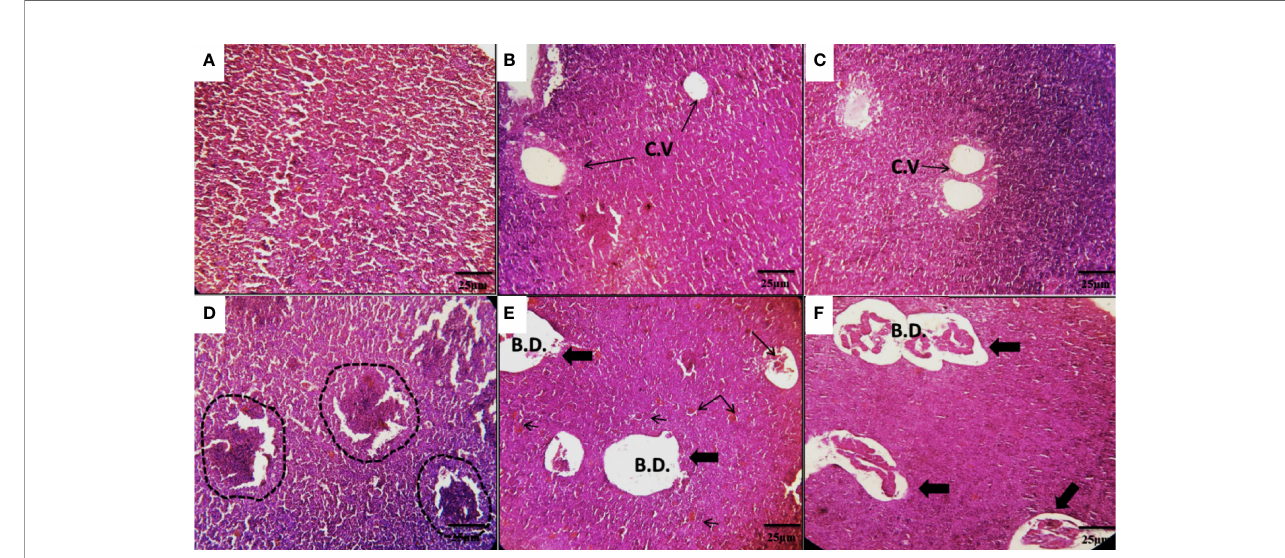
FIGURE 4 | Photomicrographs of the hepatic tissues of Nile tilapia in the CNT group (A) , and in the GEO1 and GEO2 groups for 60 days (B, C) showing normal hepatocyte architecture with normal hepatic cords around central veins. The AZT group (D) showed multi-hepatic lesions and regular condensation of hepatic tissue as a result of hypertrophy or hepatoma (dash lines). ATZ+GEO1 and ATZ+GEO2 groups (E, F) showed fewer hepatic lesions in the form of mild hepatic cholestasis with dilated bile canaliculi (thick arrows) and the trapped bile plugs diffused in the hepatic tissue (thin arrows). H&E staining, scale bar = 25 µm, C.V., central vein; B.D., bile